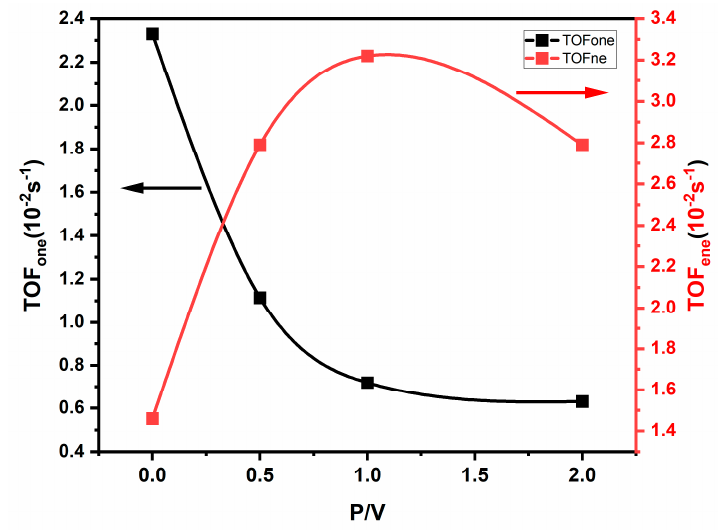
Figure 10. TOF variation of modified V 2 O 5 (3.6 wt%)/ZrO 2 catalysts in air mixture depending on P/V ratio in butenes (ene) and butanone (one) yields.